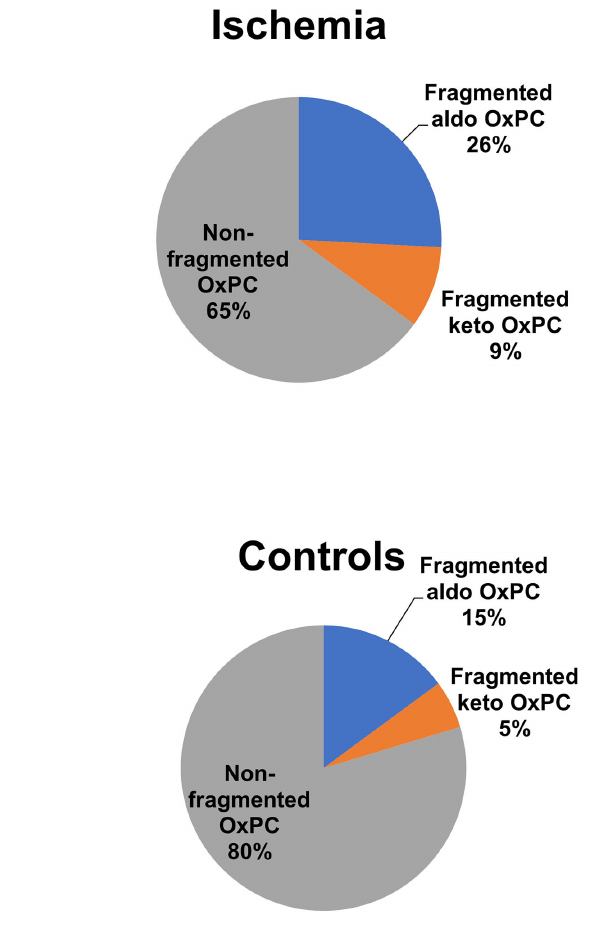
FIGURE 8 | Percentage of fragmented and non-fragmented OxPCs to total OxPCs in thrombus and plasma during